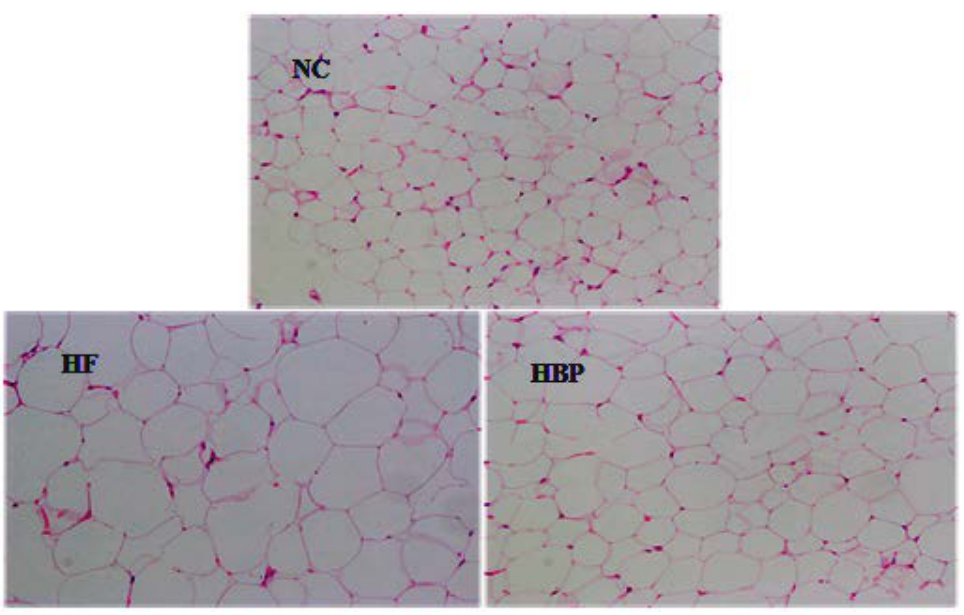
Figure 2. Representative photomicrographs of epididymal adipose tissue sections of C57BL/6J mice in NC, HF, and HBP groups (H&E staining ×